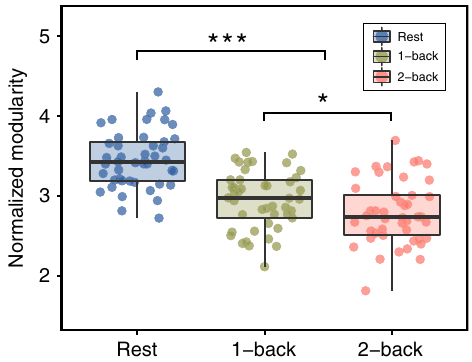
Fig. 3 Modularity differences between resting and dual n-back task conditions in “ Naive ” session. Results of paired t tests (two-sided), comparing task conditions ( n = 64). Whole-brain modularity was higher during the resting state than during the dual n-back task ( p < 0.00001), and decreased as demands heightened from the 1-back to the 2-back condition ( p = 0.01). Boxes represent the interquartile range (IR) between 25th and 75th percentiles. The thick line in the center of each box represents the median. The upper and lower error bars display the largest and smallest values within 1.5 times IR above 75th percentile and below 25th percentile, respectively. *** p < 0.001, * p < 0.05 (planned contrasts analysis; uncorrected). Source data are provided as a Source Data fi two-sided: t (39.99) = − 1.05, p = 0.30). These results indicate that